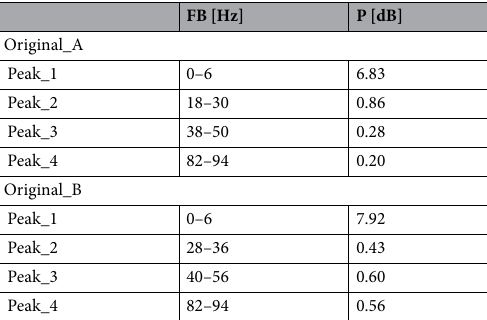
Table 1. Frequency bands (FB) and power signal (P) of the four peaks identified from the power spectrum of the Original_A and Original_B